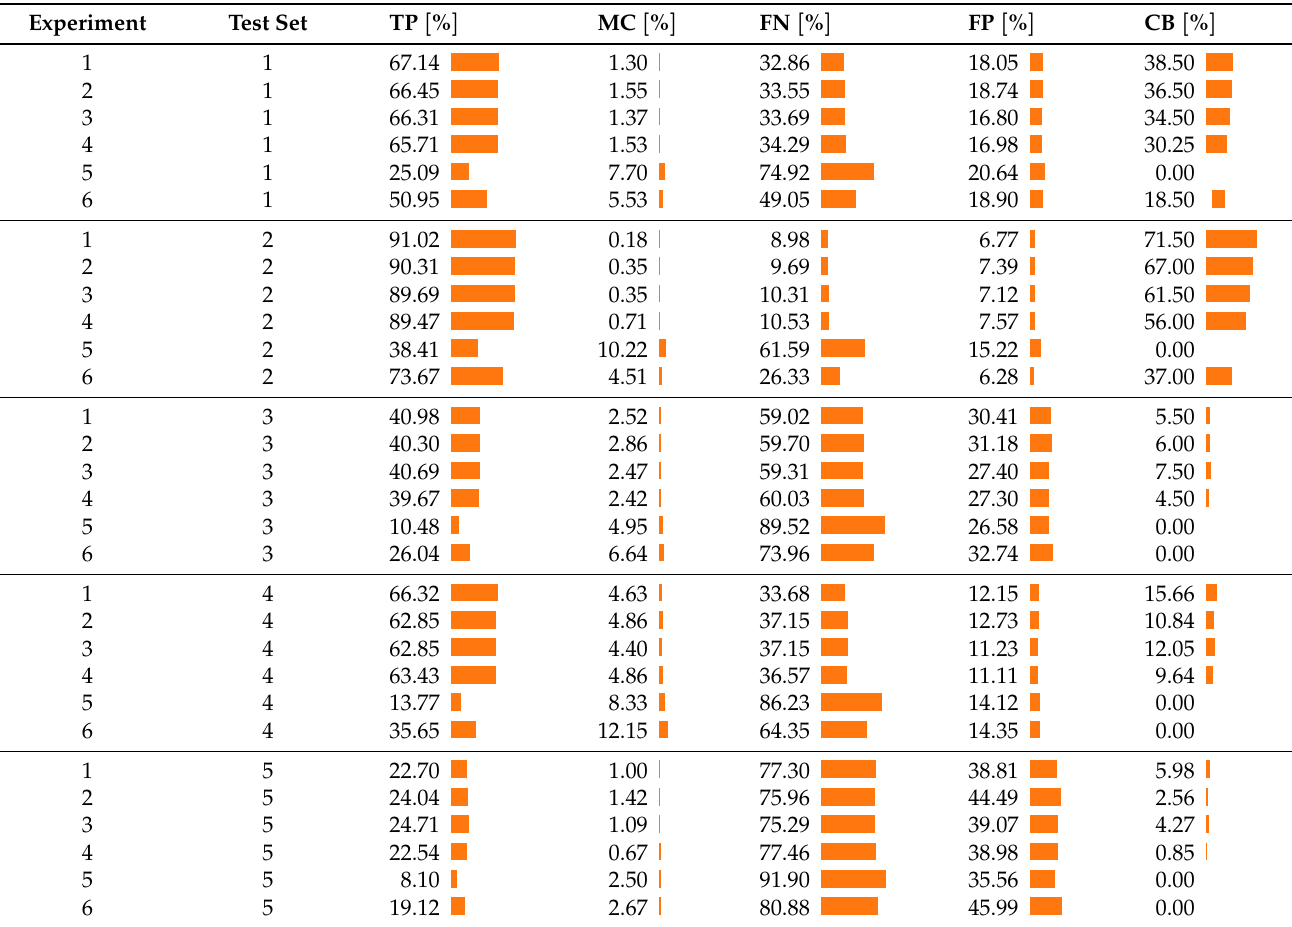
Table 3. Model performances regarding the chosen metrics. The orange horizontal bars represent the magnitude of the respective numeric